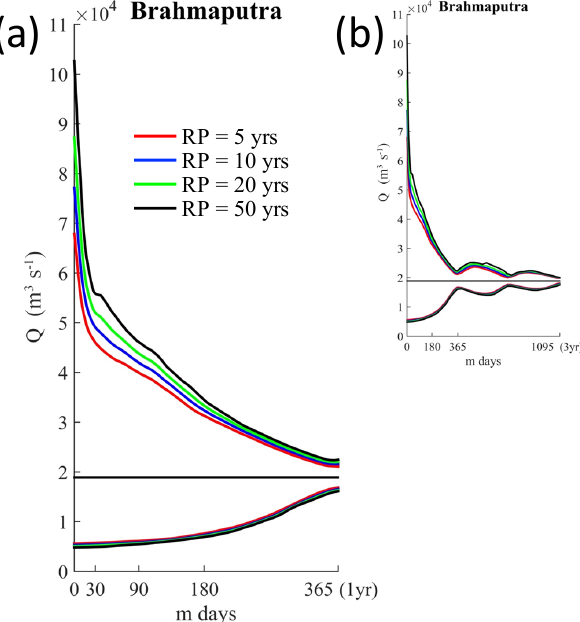
Figure 4. FDC-DDCs of the Brahmaputra River at Bahadurabad station (a) for 1 year and (b) for 3 years. The discharge data were simulated by BTOPMC with